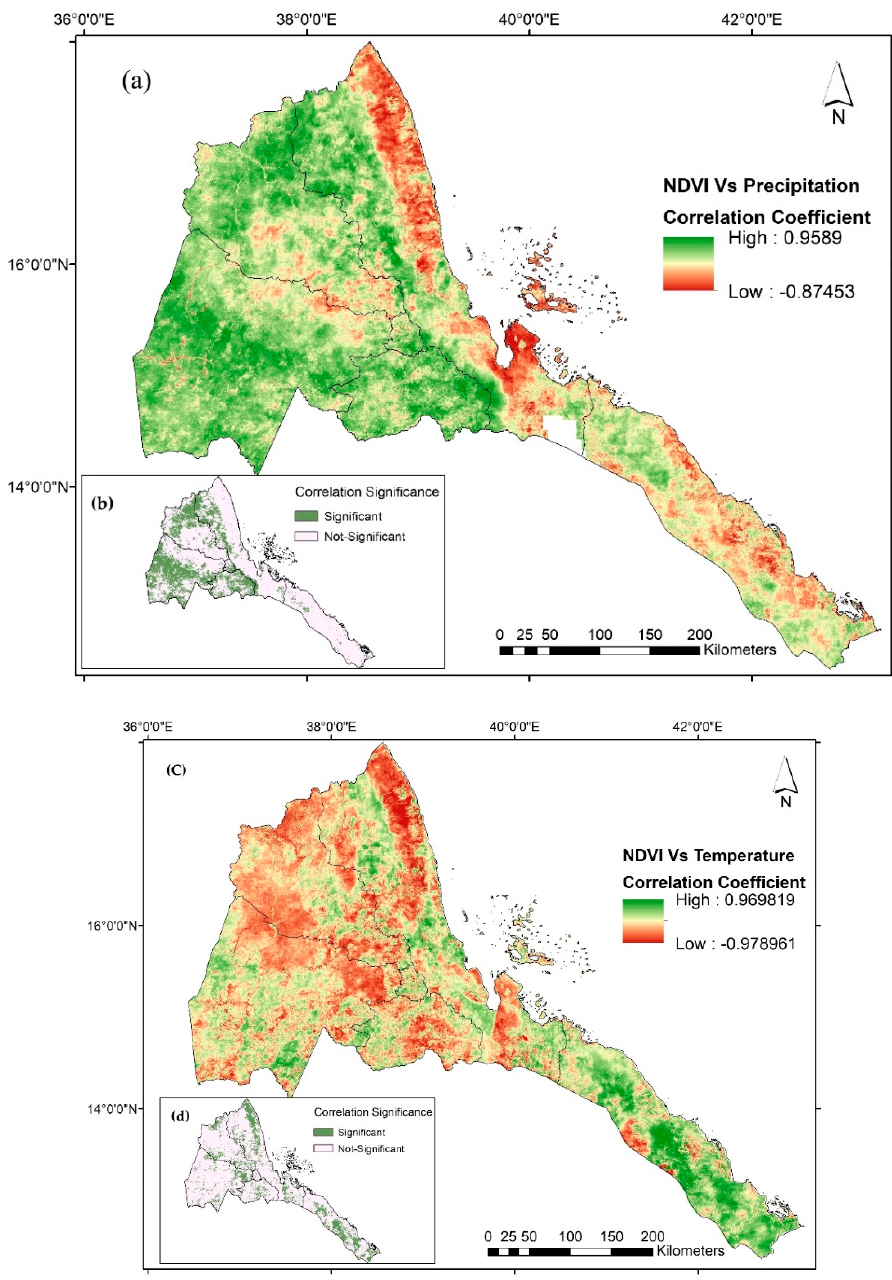
Figure 7. Correlation coefficient between annual mean NDVI versus average total precipitation ( a ) and mean annual temperature ( c ) during 2000–2017 in Eritrea; respective correlation significances ( b , d ).